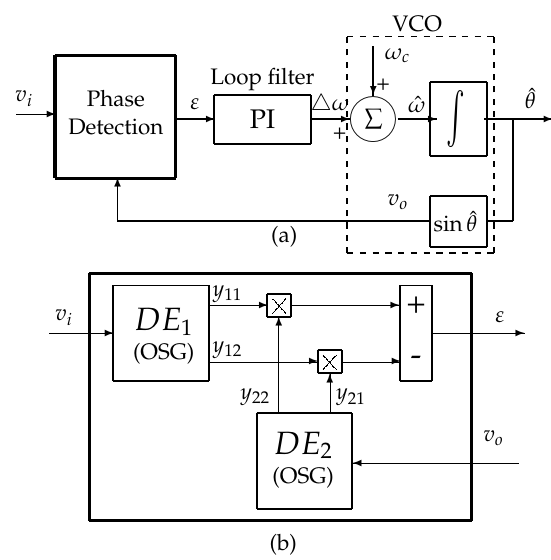
Figure 1. DE_PLL. ( a ) Basic structure. ( b ) Phase detector.